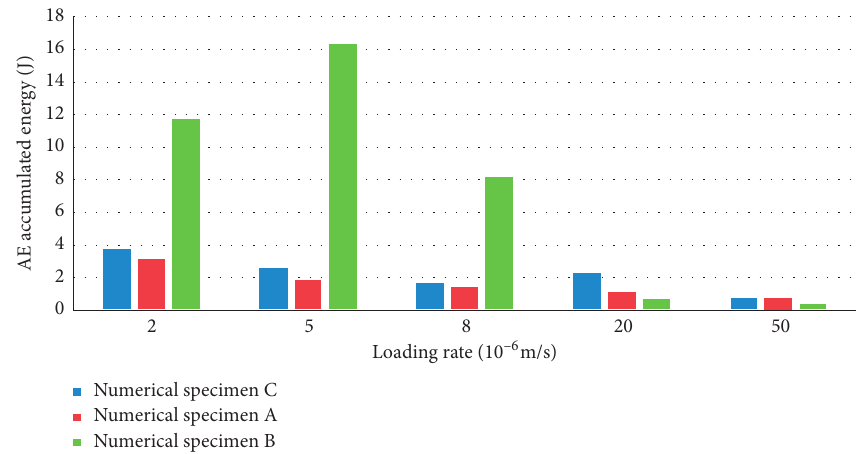
Figure 12: Longitudinal contrast of AE accumulated energy of three kinds of numerical